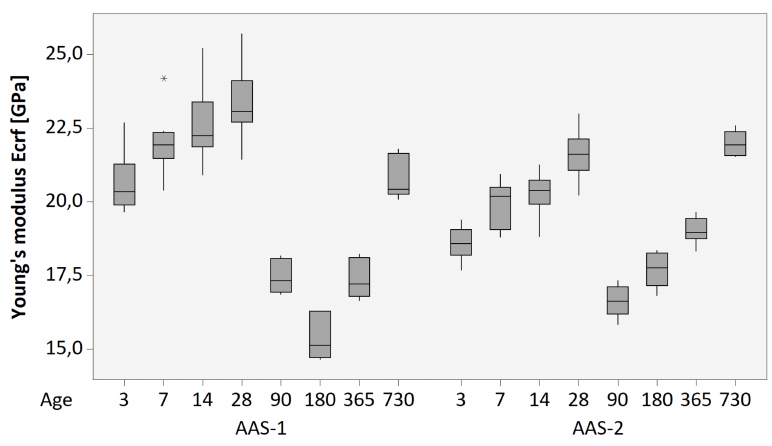
Figure 4. Box plot of the development of the Young’s modulus E